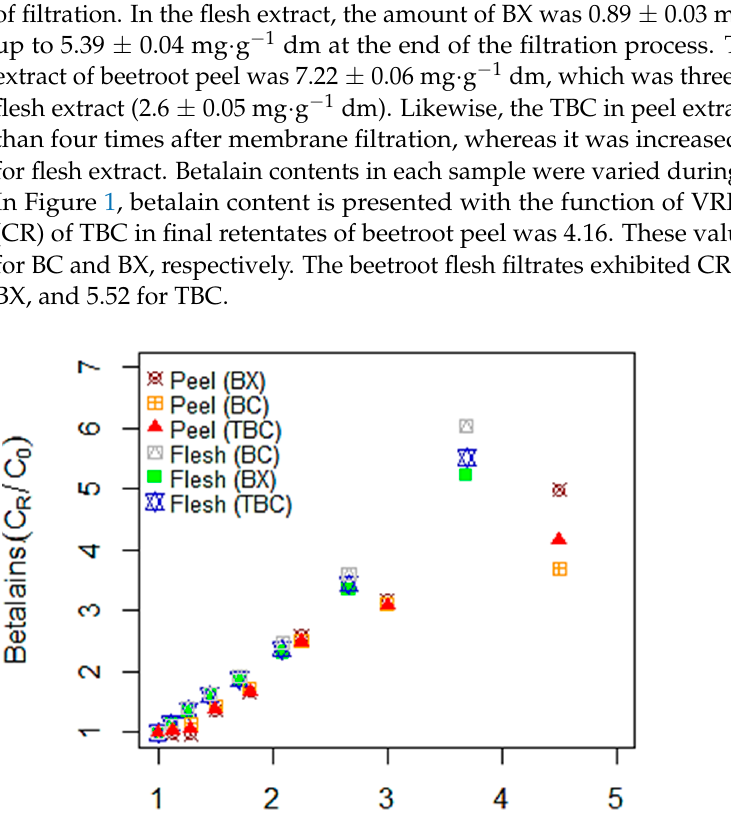
Figure 2. Variation of TPC with VRR during concentration by RO membrane (X20). AA in beetroot peel and flesh extracts were recorded as 6.5 ± 0.09 mg ASE·g − 1 dm and 1.00 ± 0.04 mg ASE·g − 1 dm, respectively (Table 1). It went up to 24.65 ± 1.42 mg ASE·g − 1 dm for peel extract, and 11.6 ± 0.1 mg ASE·g − 1 dm for flesh extract at the end of membrane filtration. Antioxidant component in each sample along with VRR is presented in Figure 3. It is noted that the CR of antioxidant content for both peel and flesh extracts are in- creased drastically with increase of VRR. CR for antioxidant for beetroot peel and flesh were 3.8 and 11.6, respectively, at the end of filtration.